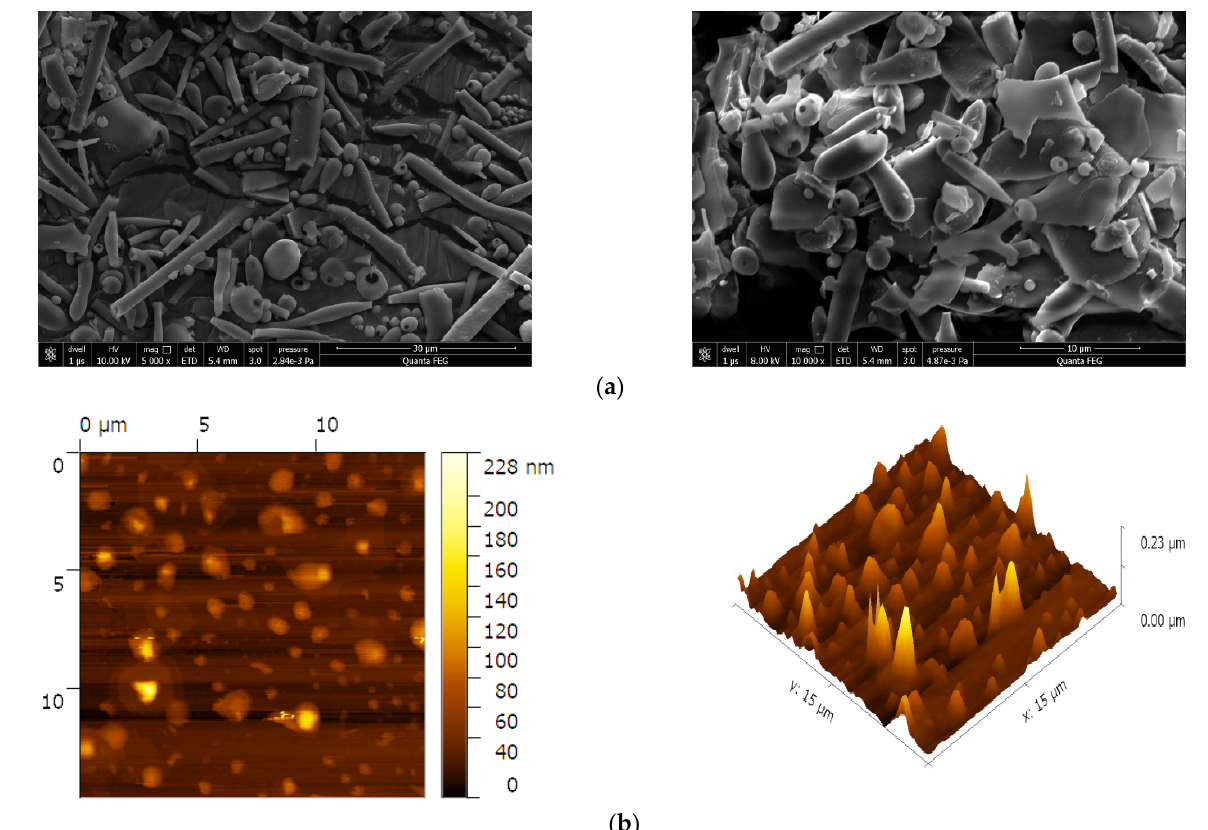
Figure 6. SEM ( a ) and AFM ( b ) image of OFP.